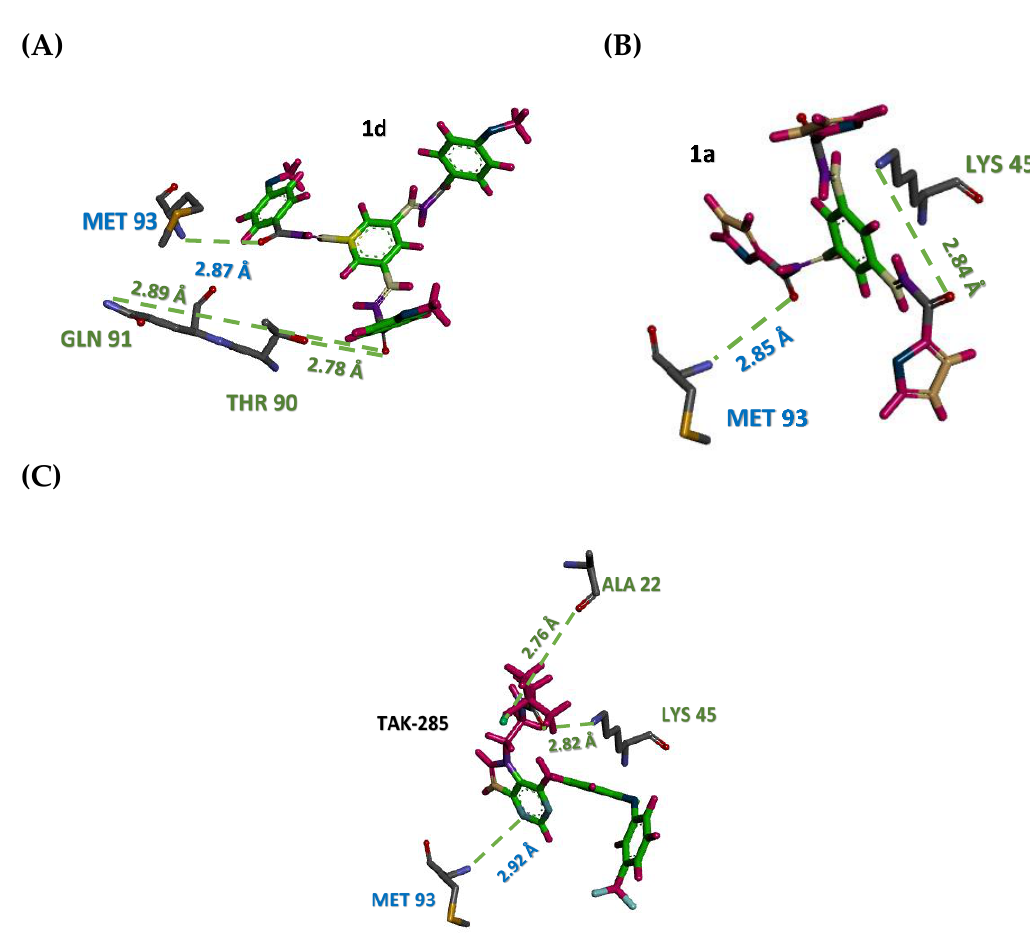
Figure 7. Stick representation of simulated compounds 1a ( A ), 1d ( B ) and TAK-285 ( C ) site forming hydrogen bond (green dots) interactions with amino acid residues in the active. MET 93 amino acid found to participate in the hydrogen bond interaction with the three simulated compounds.